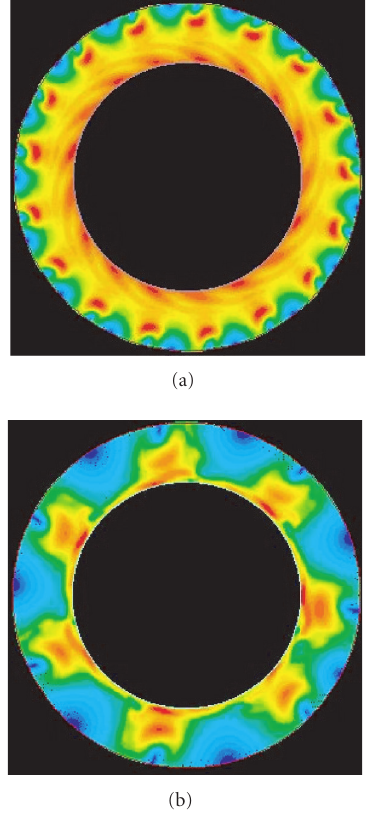
Figure 2: (a) Stable operating condition and (b) two-dimensional rotating